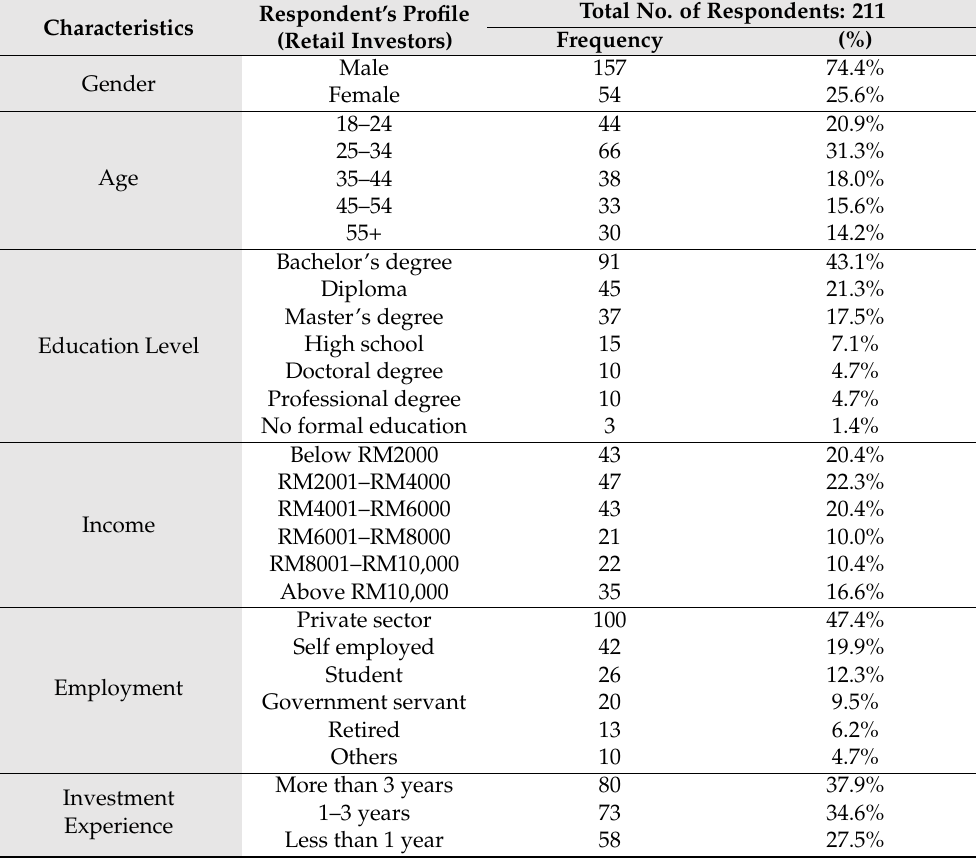
Table 2. Investors’ demographic